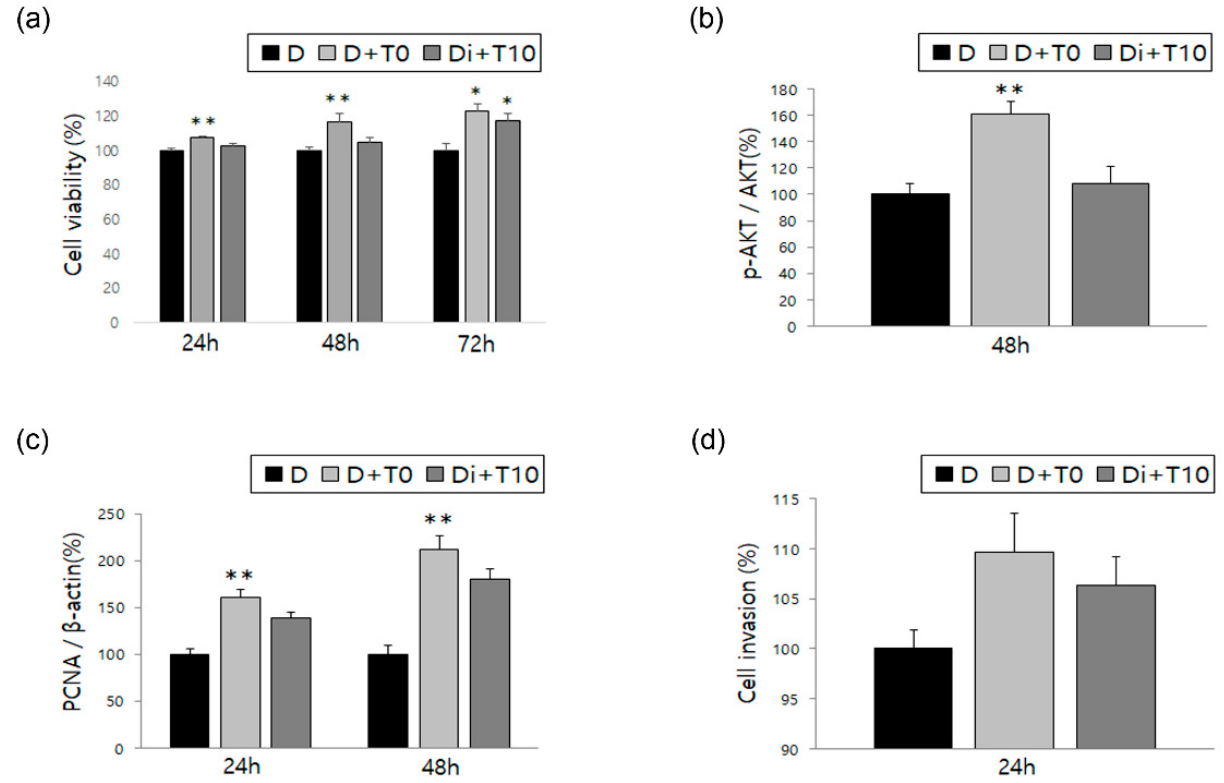
Figure 2. Effect of DNG with tumor necrosis factor alpha (TNF- α ) on human ESCs. Time-dependent variation evaluated in the three groups for the following factors: ( a ) cell viability, ( b ) AKT phosphorylation, ( c ) expression of PCNA, and ( d ) cell invasion. Error bars show the mean ± SEM. * p < 0.05 versus control, ** p < 0.05 versus control as well as treatment with both DNG and TNF- α in ESCs. D = ESCs in DMSO solution (control); D + T10 = treated with TNF- α 10 ng/mL; Di + T10 = treated with DNG 10 − 6 M and TNF- α 10 ng/mL. Data are expressed as a percentage, wherein cells treated with the vehicle are normalized to 100%.